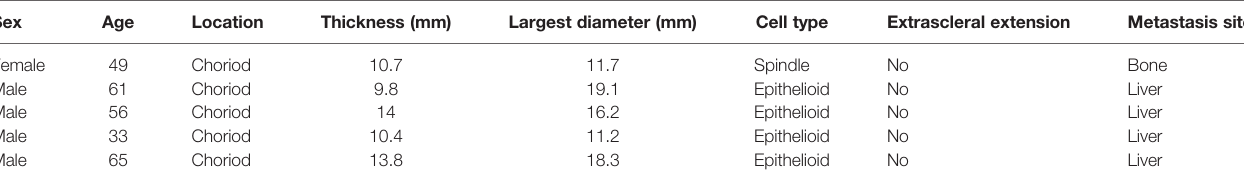
TABLE 3 | Data of patients with metastatic